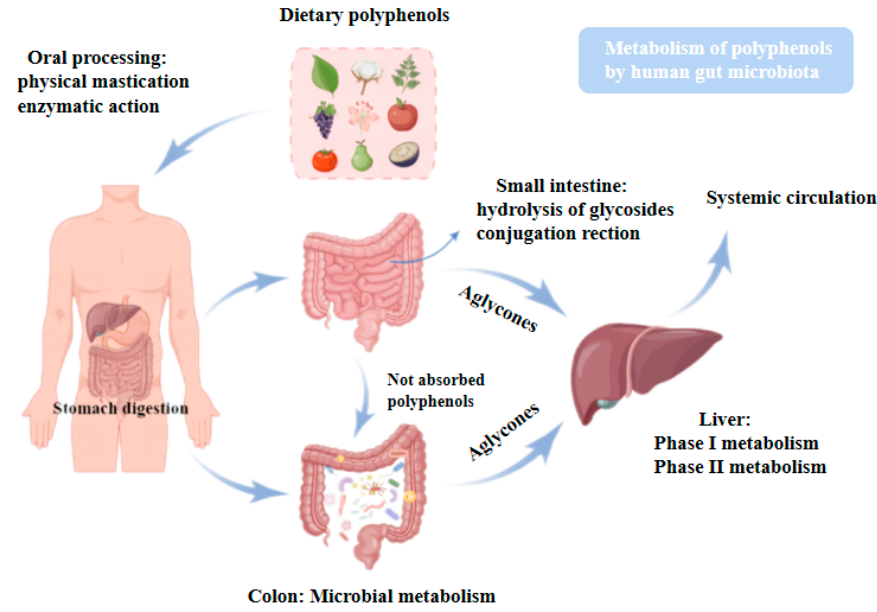
Figure 1. The metabolism of polyphenols by the human gut